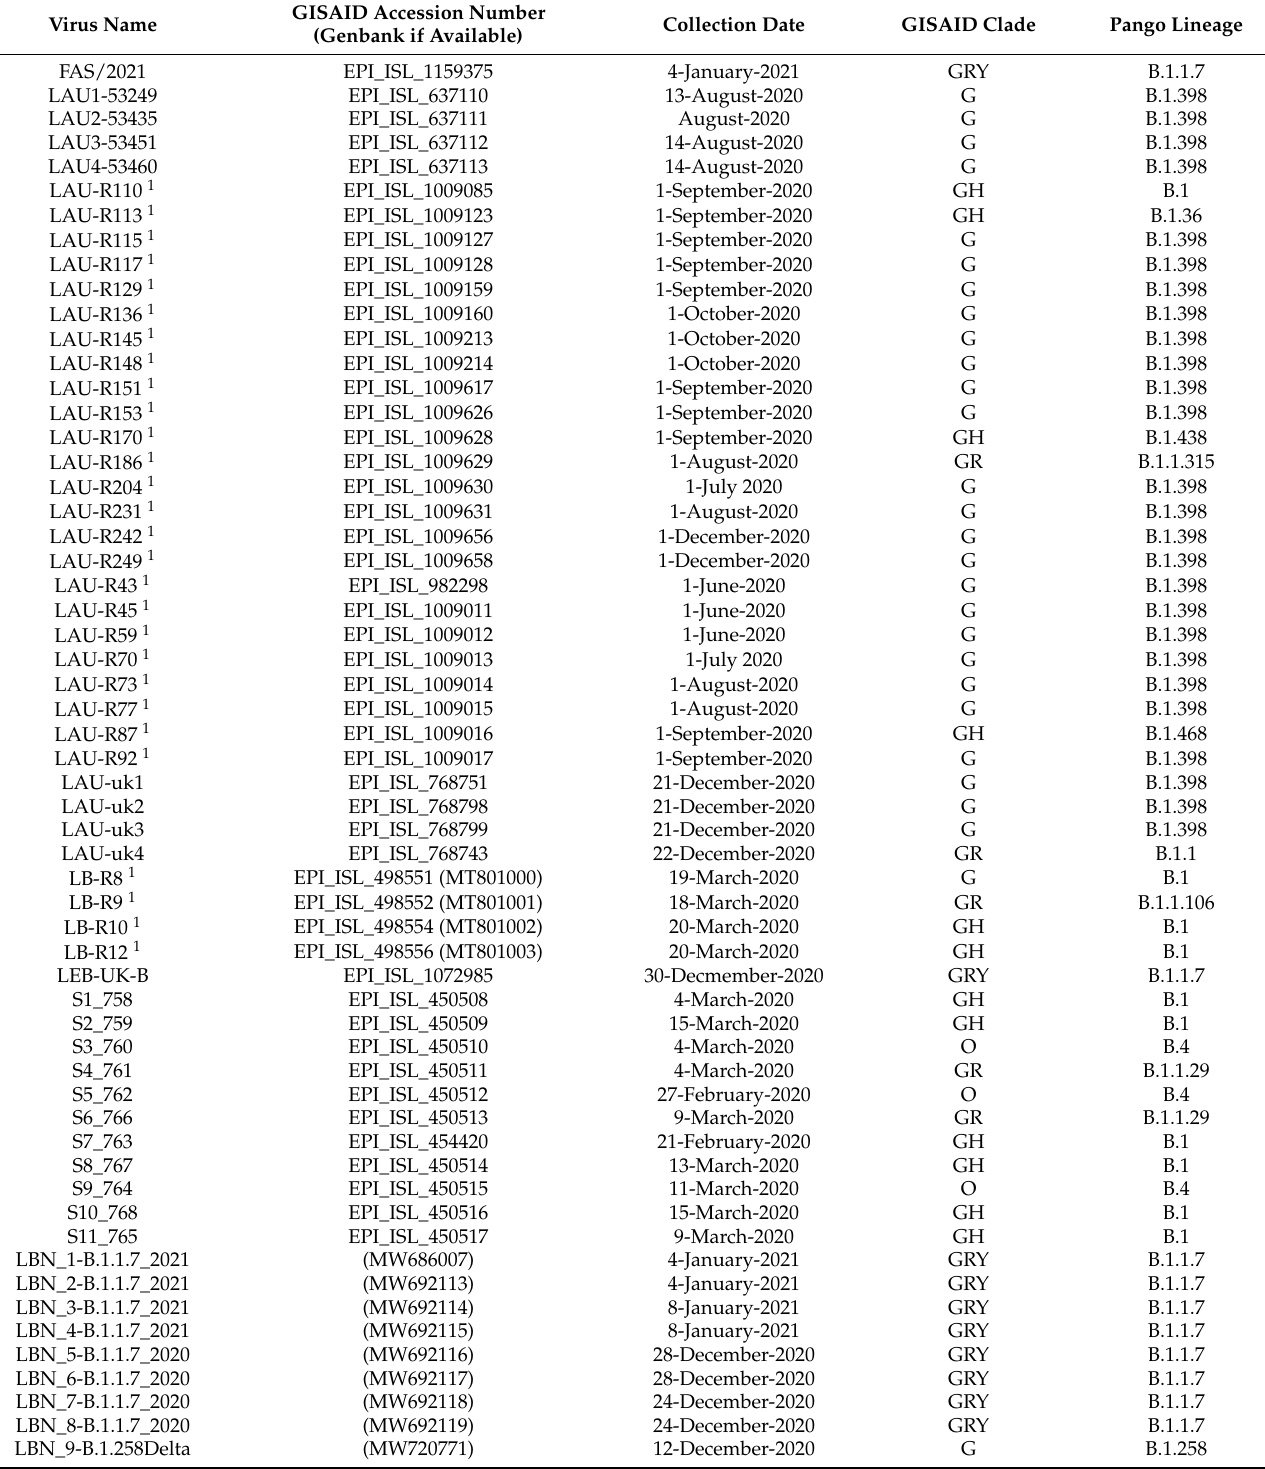
Table 1. Analyzed Lebanese SARS-CoV-2